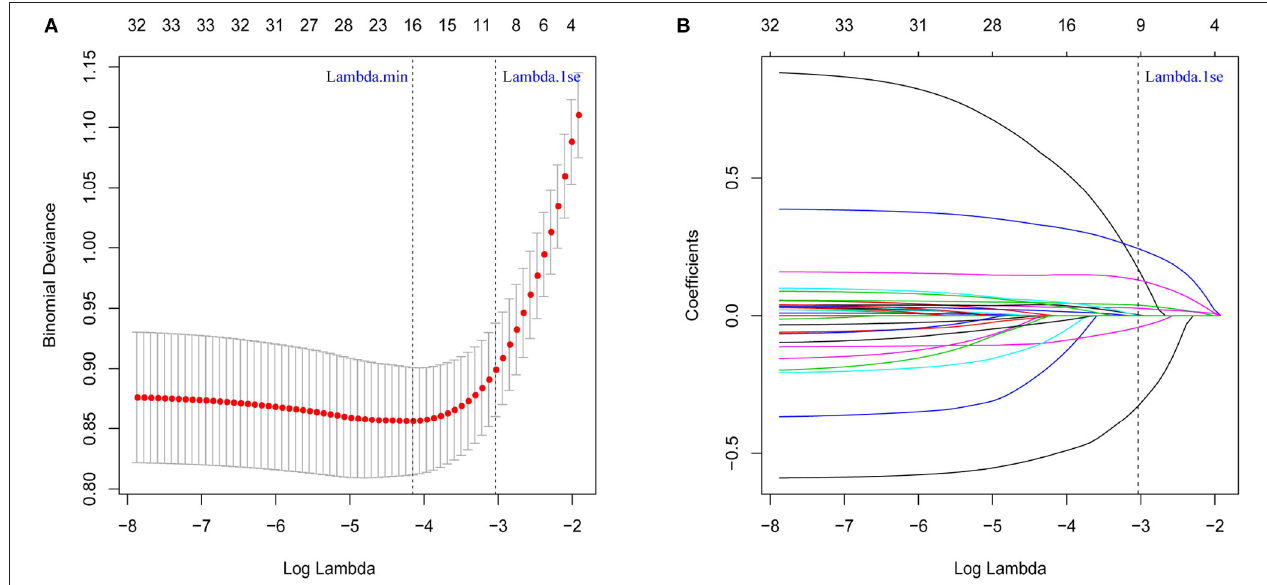
FIGURE 1 | Determination of Internet Gaming disorder risk factors in children and adolescents by least absolute shrinkage and selection operator (LASSO) regression analysis. (A) The cross-validation for LASSO regression, where the parameter lambda was adjusted to find the best function set, is shown. The vertical dotted line on the left panel represents the log (lambda) corresponding to the optimal lambda. (B) The coefficients of predictors changed with lambda. The vertical dotted line in the right panel corresponds to the eight features selected with non-zero LASSO cross-validation coefficients.